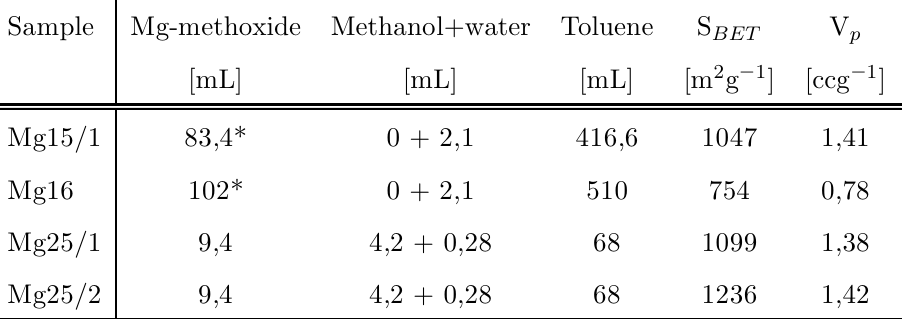
BET , and total pore